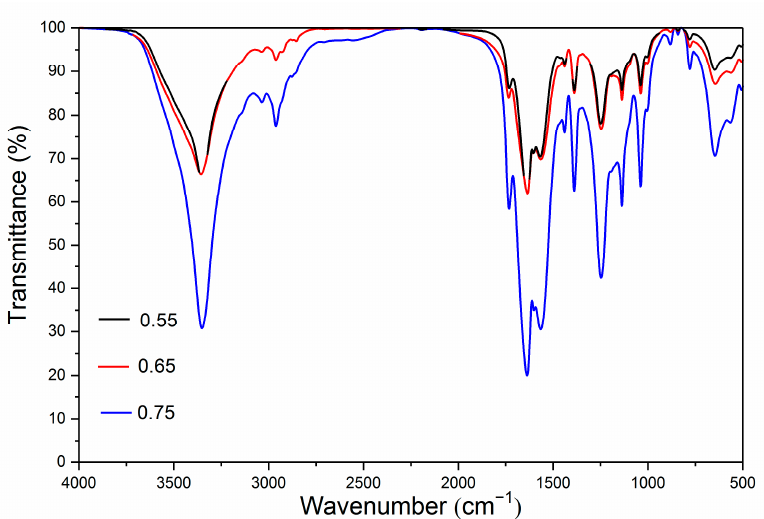
Figure 6. Infrared spectrum of microcapsules with different ratios of core materials to shell material in mass.